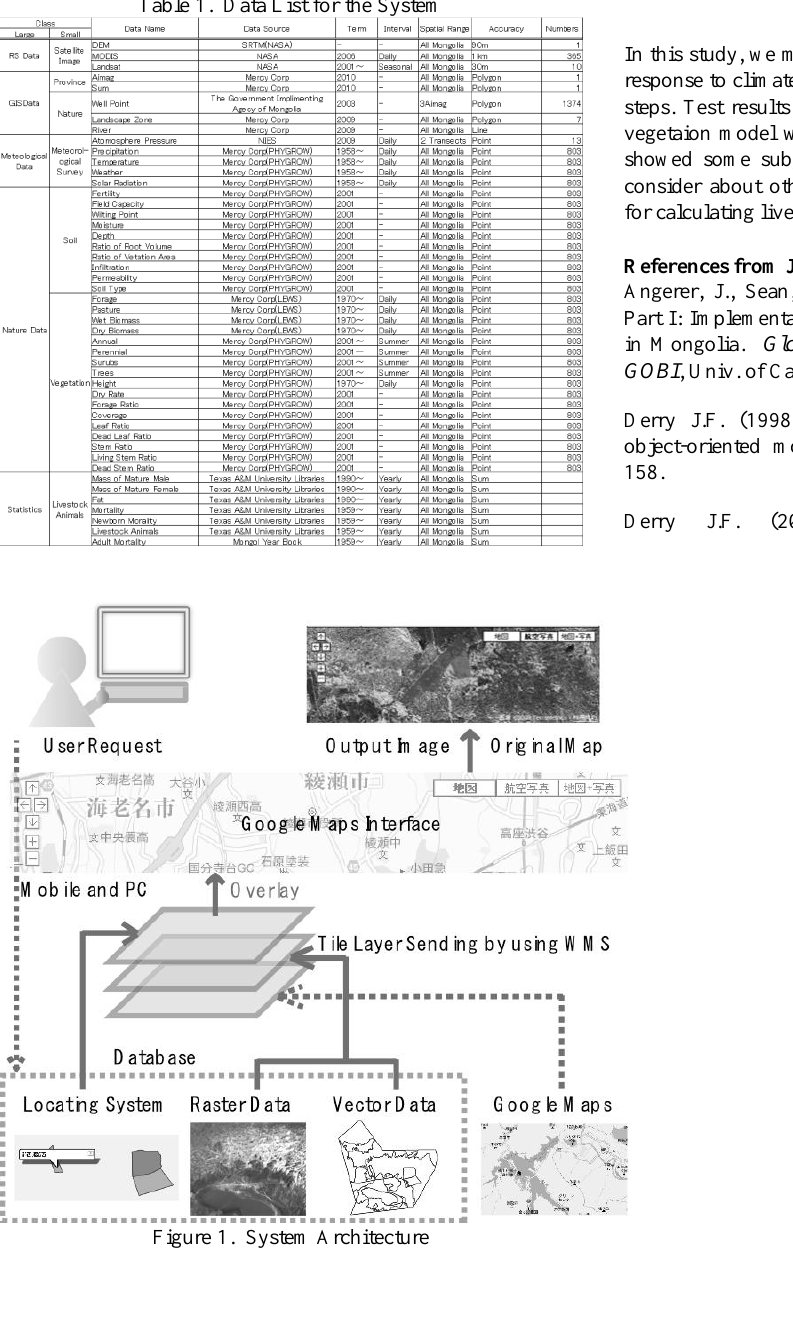
Table 1. Data List for the System